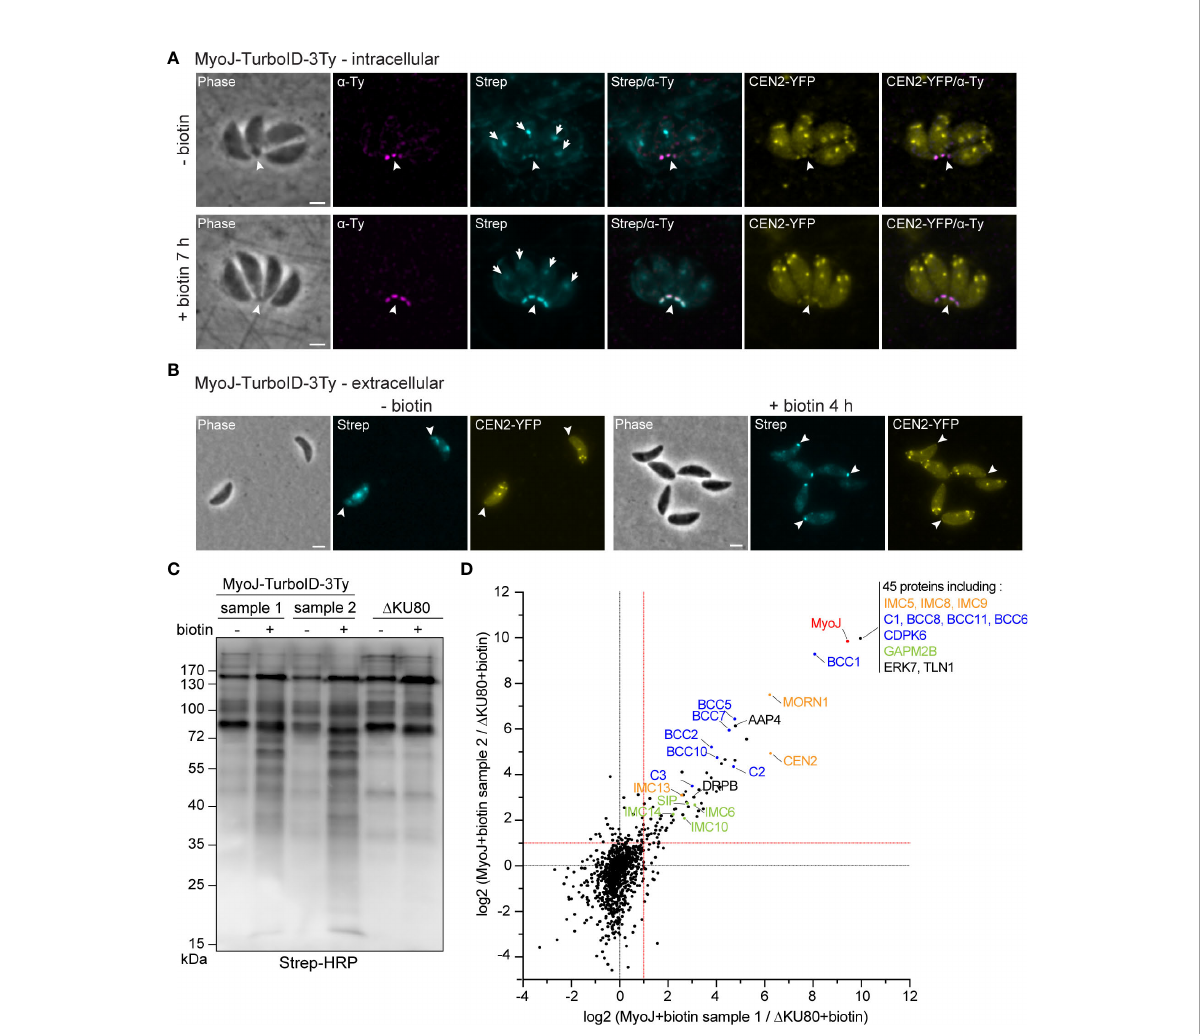
FIGURE 1 Identi fi cation of putative MyoJ-interacting proteins using TurboID. Immuno-detection of MyoJ endogenously tagged with TurboID-3Ty (MyoJ- TurboID-3Ty) in intracellular (A) and extracellular (B) tachyzoites also expressing endogenously tagged CEN2 (CEN2-YFP). MyoJ-TurboID-3Ty localizes at the basal end of the parasite (arrowhead). Biotinylated proteins are detected using a fl uorophore-conjugated streptavidin (Strep). In absence of biotin, mainly the apicoplast (arrow) of each parasite is labelled with a weak signal at the posterior pole. In contrast, after incubation with biotin, mainly the posterior pole is stained. Magenta: mouse anti-Ty, Cyan: streptavidin-AlexaFluor 594, Yellow: CEN2-YFP. Scale bars: 2 m m. (C) Western blot of biotinylated proteins, isolated with streptavidin magnetic beads after incubation of egressing D KU80 and MyoJ- TurboID-3Ty parasites ± biotin for 7 h. Revelation was performed using streptavidin-HRP. (D) Scatter plot of the log2(ratio) of the proteins found in the two replicates (samples 1 and 2). The bait MyoJ is shown in red, the candidates investigated in this study (CX and BCCX) are in blue, the known basal complex proteins in orange, the known IMC proteins in green, and the other known proteins in